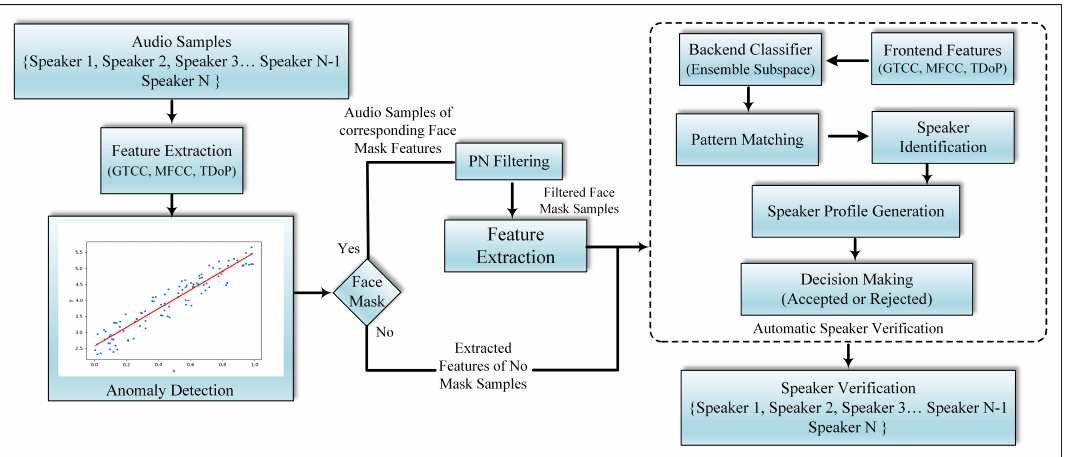
Figure 4. Proposed architecture for automatic speaker